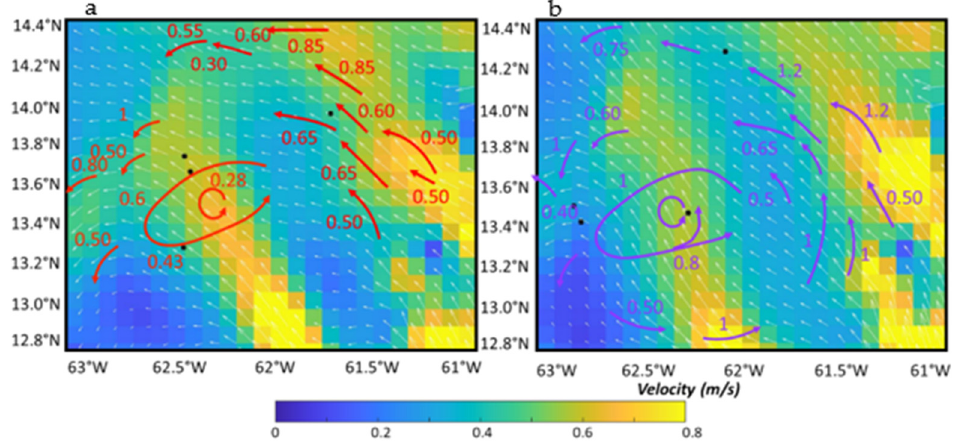
Figure 12. Modeled surface velocity (combining large scale current velocity, wind velocity, Stokes velocity): ( a ) On 8 August 2018 and ( b ) on 9 August 2018; speed and direction are shown using color scale and white arrows respectively. The drift of aggregations derived from GOES data (red and purple arrows for 8 and 9 August, respectively) was superimposed to ease the comparison between observed and modeled motion.